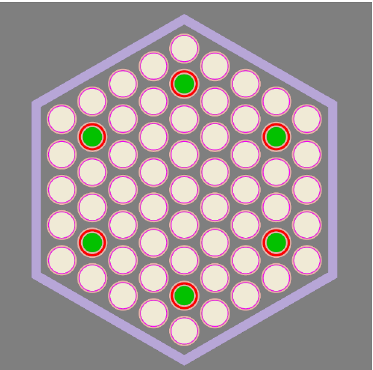
Figure 2: Generic LFR fuel assembly with six ARC tubes implemented. Note: Not to